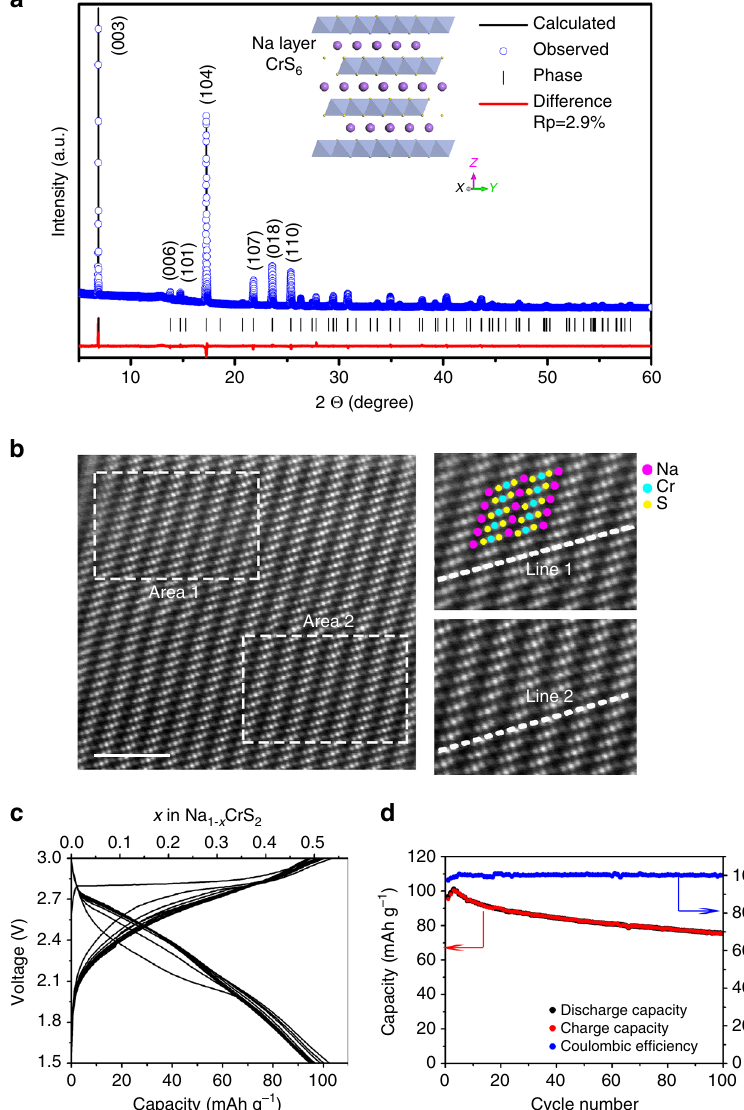
Fig. 1 Structural, morphological, and electrochemical performance of NaCrS 2 . a XRD patterns of powder NaCrS 2 ( blue circle ), calculated pro fi le ( black solid line ), and their difference ( red solid line ). Bragg positions are indicated as black vertical tick marks . In the inset for the structure schematic of NaCrS 2 , legend: purple (Na), blue (Cr), and yellow balls (S); b HAADF-STEM image of the pristine NaCrS 2 particle, scale bar 2 nm; c Galvanostatic charge/discharge curves, d cyclic performances and Coulombic ef fi ciencies of NaCrS 2 electrode at 0.5